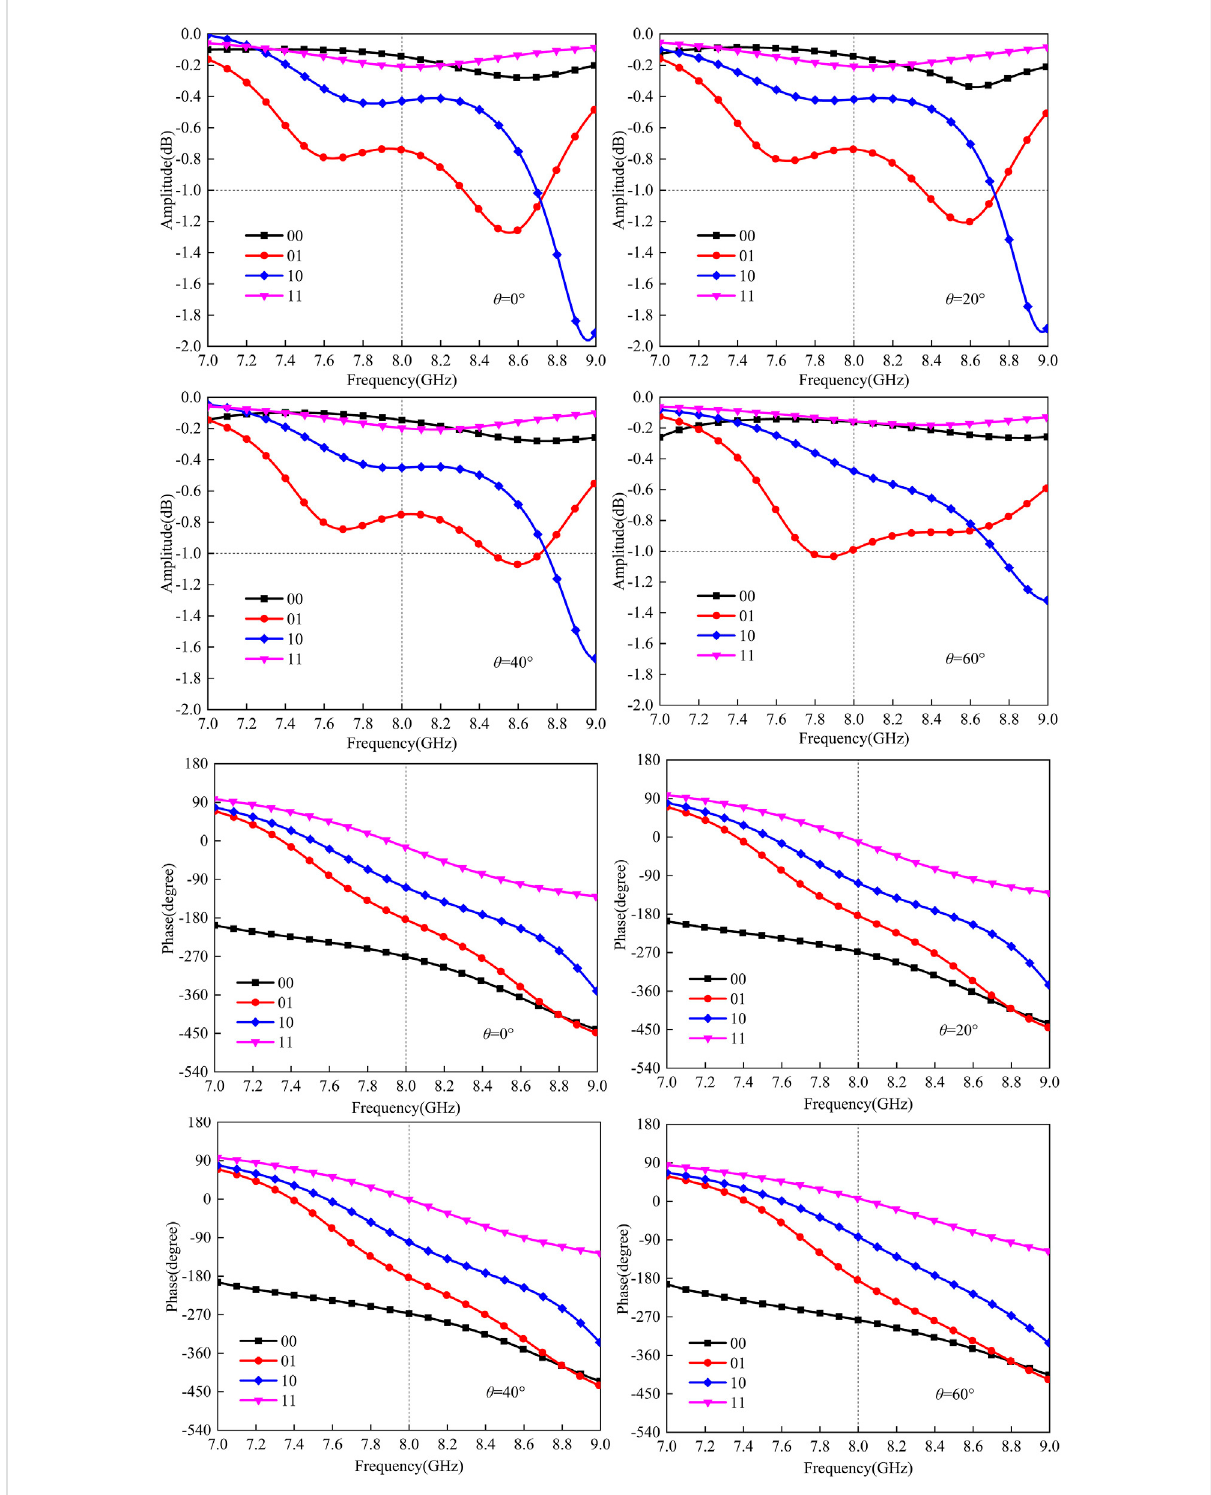
FIGURE 2 Amplitudes and phases of four types of meta-atoms in θ = 0 ° , 20 ° , 40 ° , and 60 ° from 7 to 9 GHz.